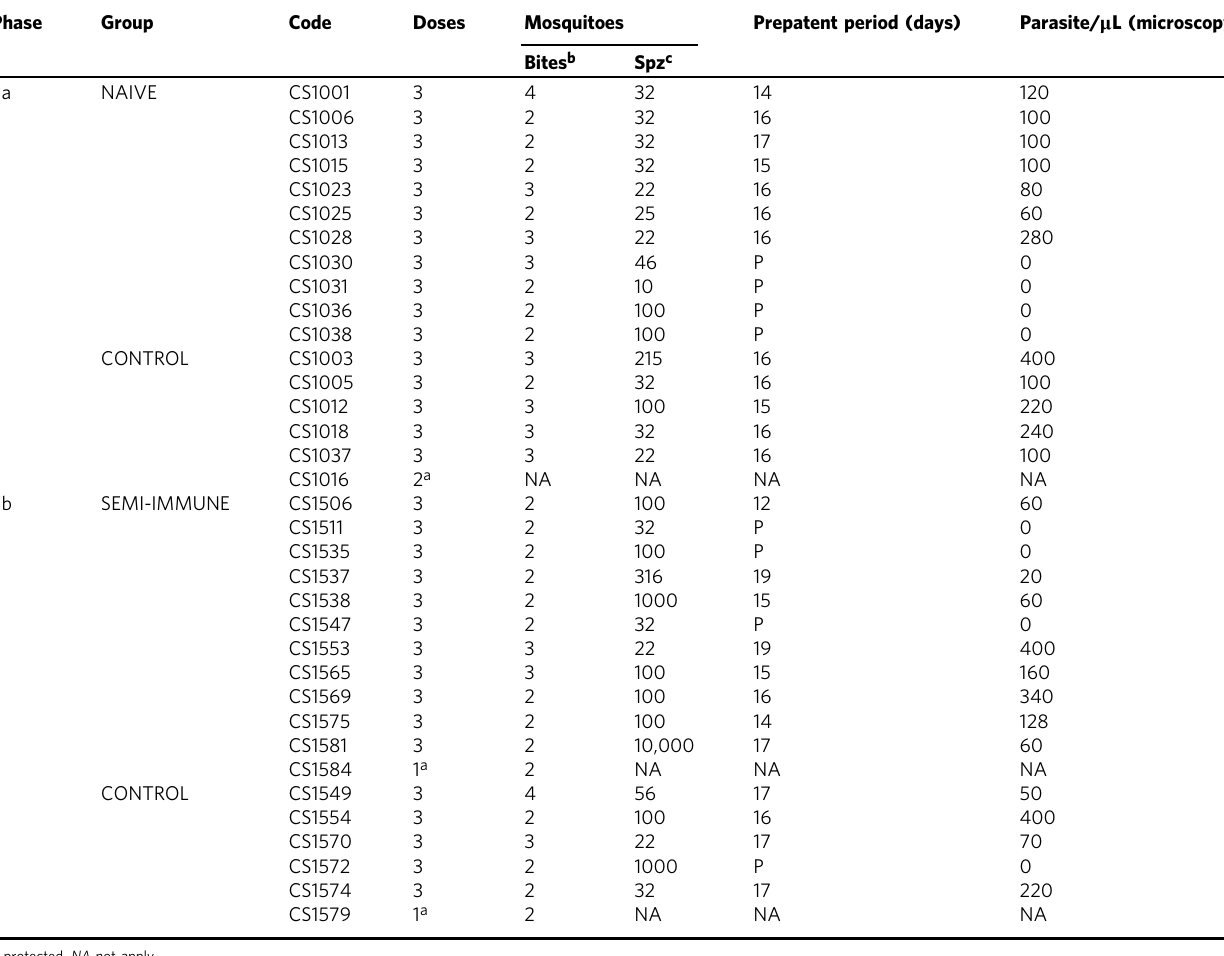
Table 3 Description of the CHMI and infection outcomes.